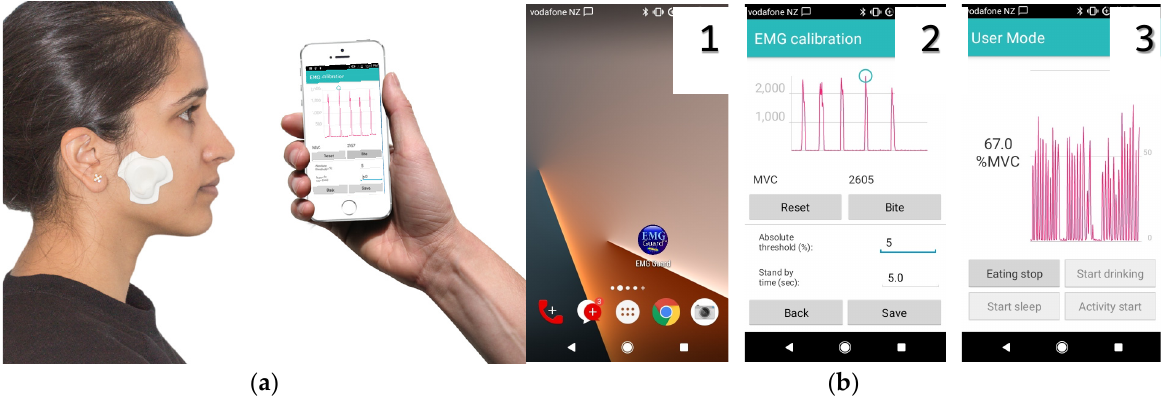
Figure 3. Wearable sEMG device for MMA monitoring: ( a ) an android smartphone is used for logging and displaying muscle activity in real-time; ( b ) a dedicated smartphone app (1) helps in initial calibration (2) and recording of MMA that is displayed graphically on the screen in real-time. Note the multiple rhythmic medium amplitude spikes characteristic of chewing activity (3).